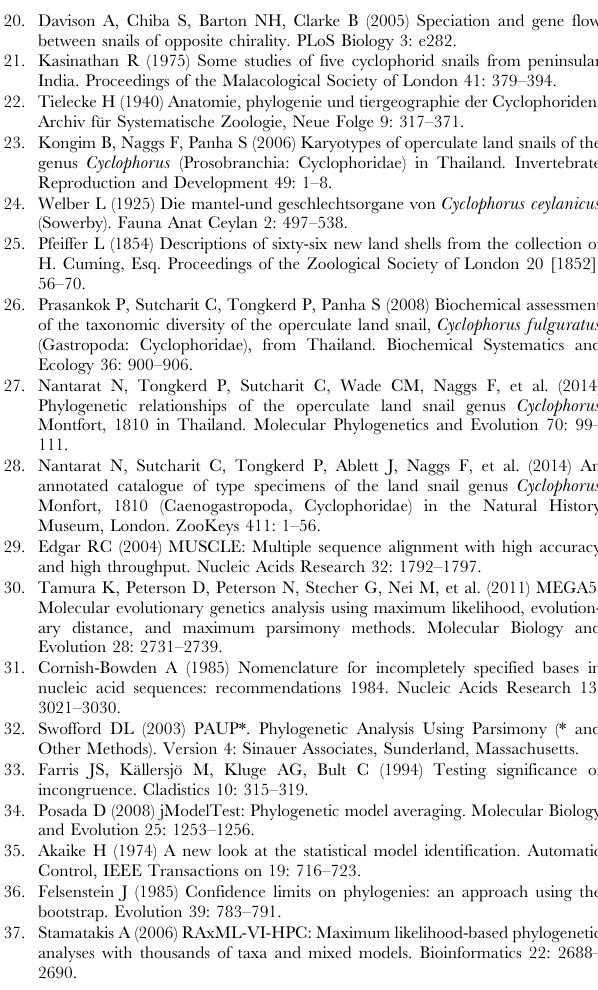
Figure S1 Maximum-likelihood phylogenetic tree of the Cyclo- phorus fulguratus species complex and related species constructed using the 18S gene (431 bp). Figure S2 Maximum-likelihood phylogenetic tree of the Cyclo- phorus fulguratus species complex and related species constructed using the 28S gene (585 bp). Figure S3 Maximum-likelihood phylogenetic tree of the Cyclo- phorus fulguratus species complex and related species constructed using the 16S gene (470 bp).